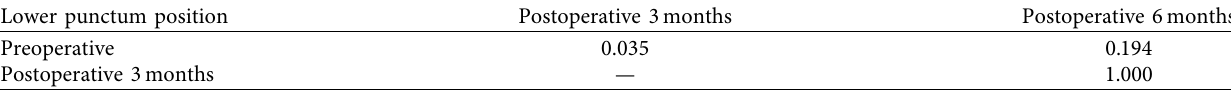
Table 2: Te results of Bonferroni correction.